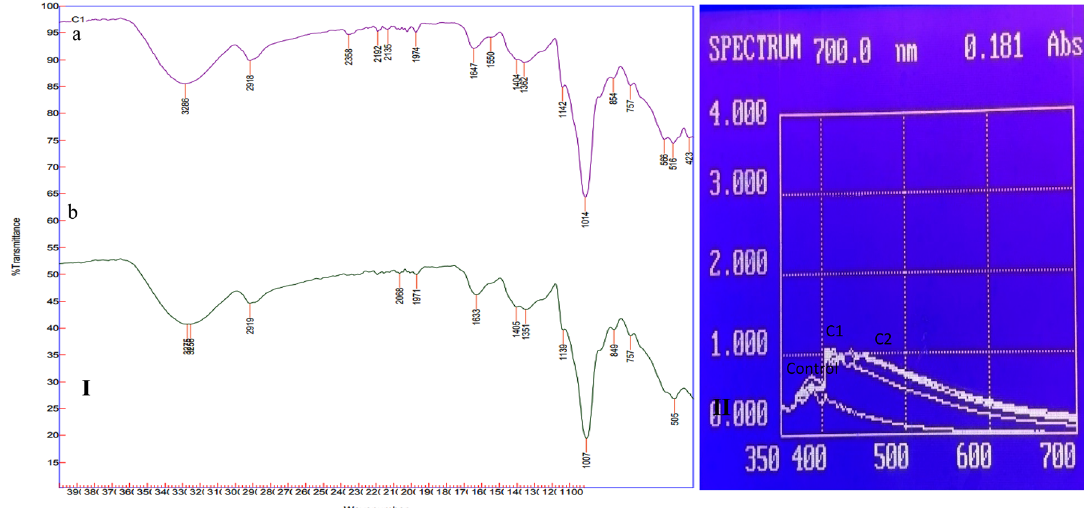
Figure 4. ( I) FTIR of ( a ) White wheat beer and, ( b ) Black wheat beer, (II) UV Spectra showing anthocyanin in the black wheat beer production using C1, C2 and control yeast